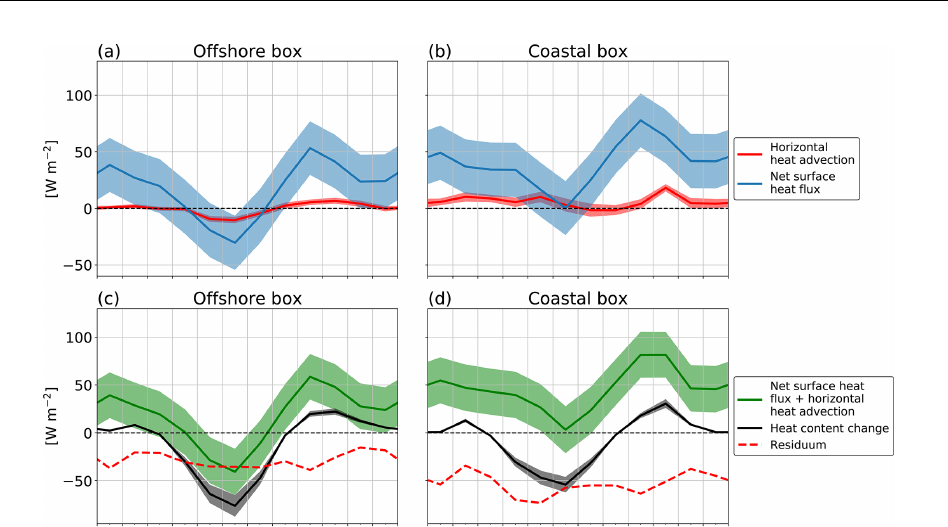
Figure 9. (a, b) Individual contributions to the ML heat budget. Colours are explained in the legend. (c, d) Sum of net surface heat flux and horizontal heat advection (green lines), the observed heat content change (black lines), and the resulting residuum between the two (red dashed line). Panels (a, c) show budget terms averaged over the offshore box, and panels (b, d) show budget terms averaged over the coastal